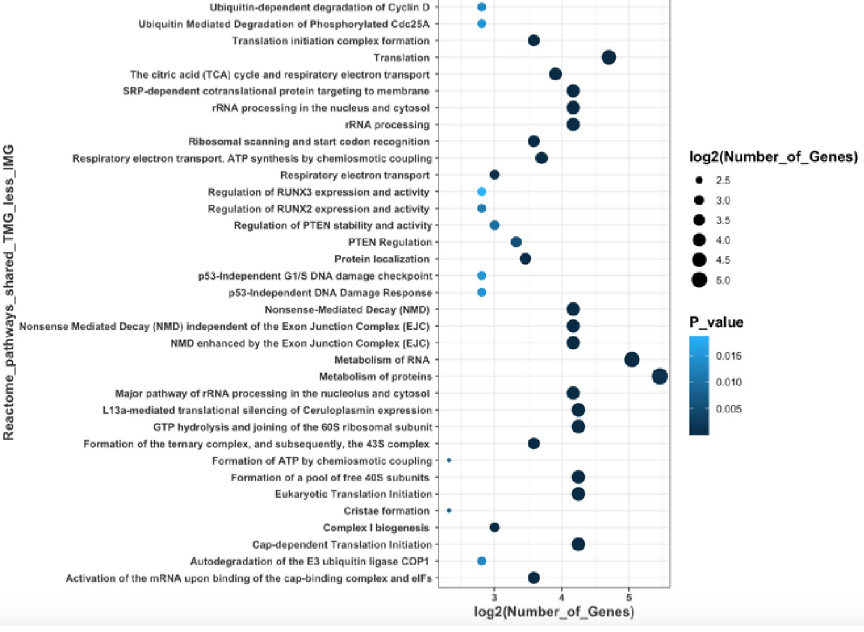
Fig 6. Reactome pathways that were downregulated in the TMG when compared to IMG in both LFD and HFD fed dams.